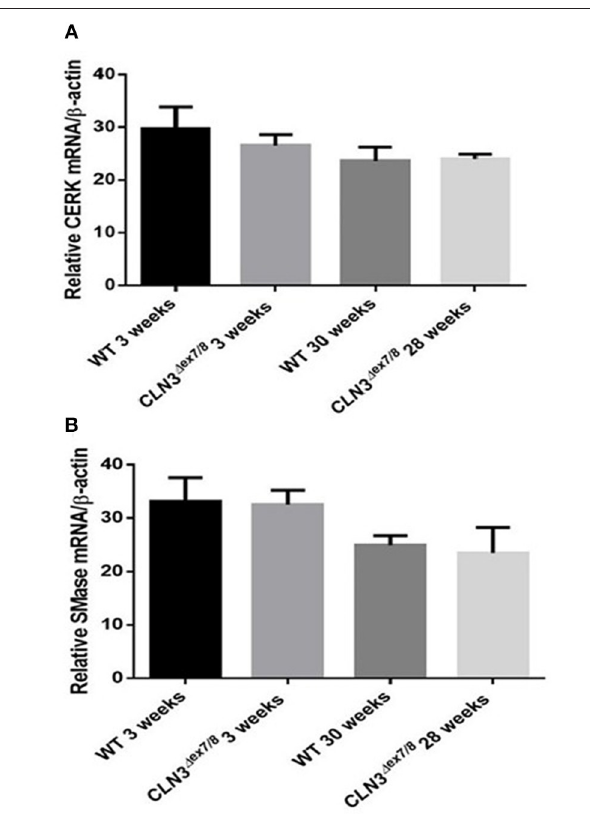
FIGURE 5 | CerK (A) and SMase (B) relative mRNA expressions were not significantly different between WT and Cln3 ∆ ex7/8 mouse brain at 3 and 28–30 weeks ( n = 3 in each group) as determined by qRT-PCR.